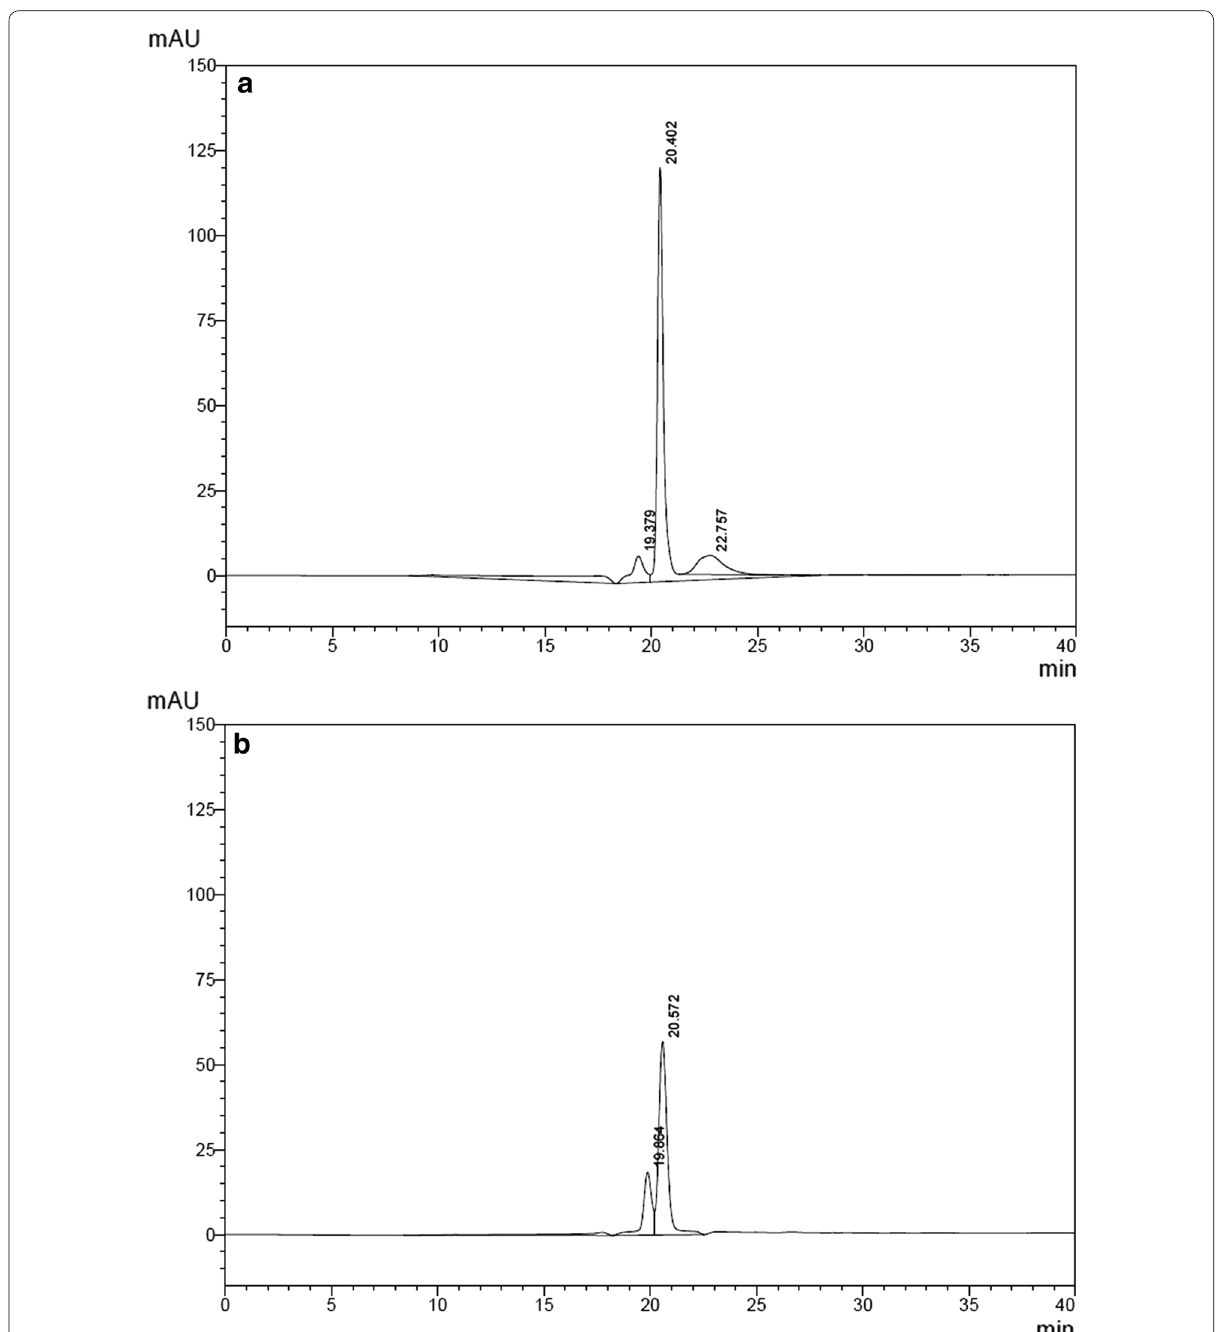
Fig. 3 High-performance size-exclusion chromatography (HPSEC) of: a E. coli -derived hBMP-2 (GenScript), 10 µg; b CHO-derived hBMP-2 (Infuse ® ), 10